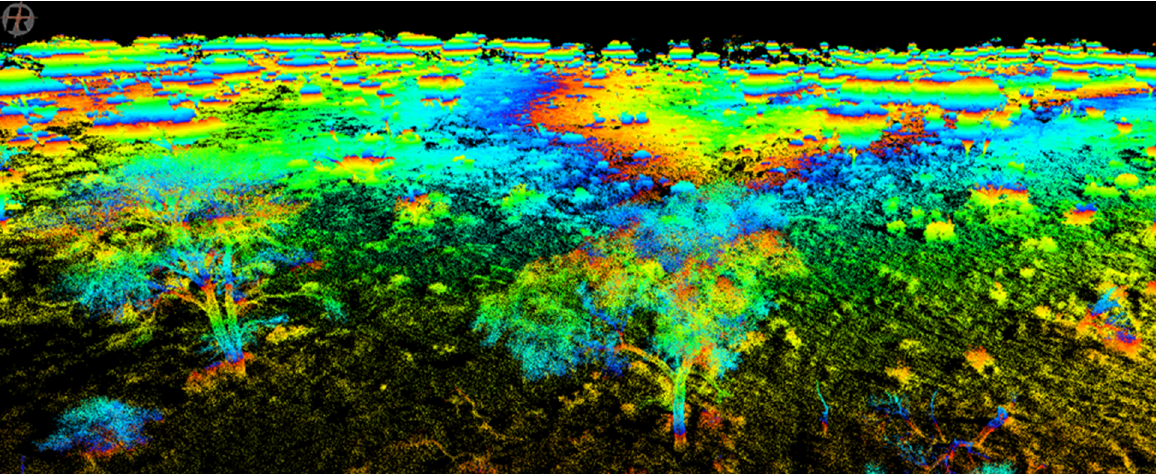
Figure 1. 3D point cloud showing the inherent heterogeneity of savanna ecosystems. The point cloud was captured with a time of flight Riegl VZ 1000 scanner in the vicinity of Skukuza Flux Tower in Kruger National Park, South Africa. One colour pass equals 5 m in height.